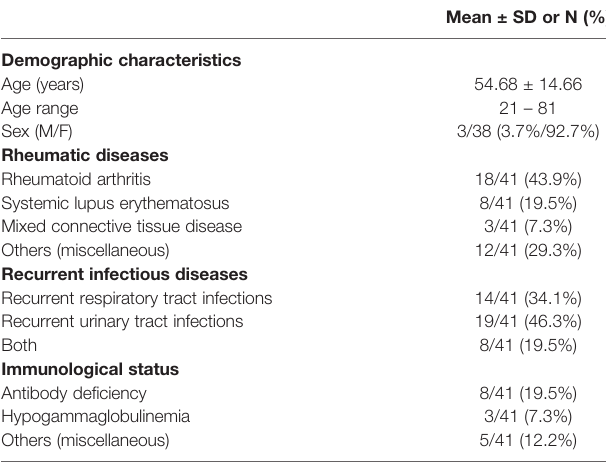
TABLE 1 | Demographic and clinical characteristics of subjects at baseline